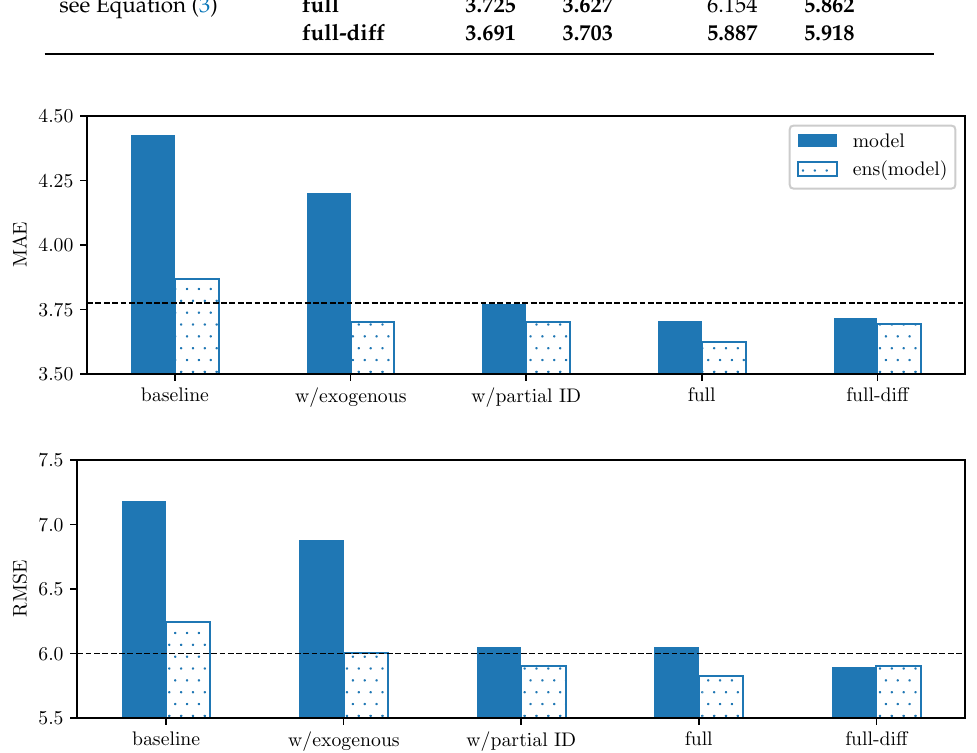
Figure 4. Bar plots illustrating the MAE ( top ) and RMSE ( bottom ) errors reported in the upper part of Table 1, that is, for the naïve benchmark and models that utilize back-transformation (4). The black dashed lines correspond to the benchmark, the solid bars represent the individual models and the dotted bars the corresponding